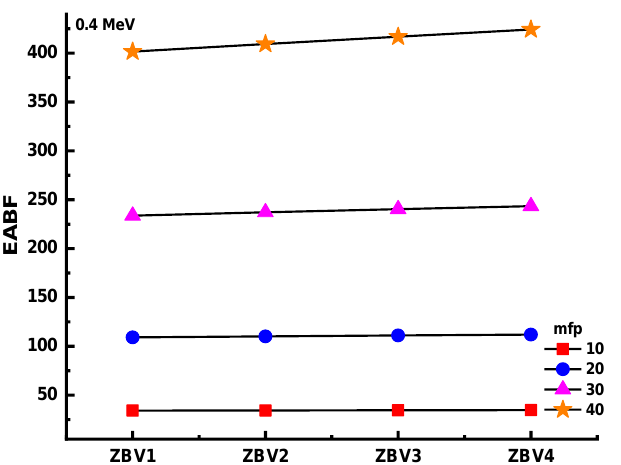
Figure 11. Variation of exposure buildup factor (EBF) against glass compositions.